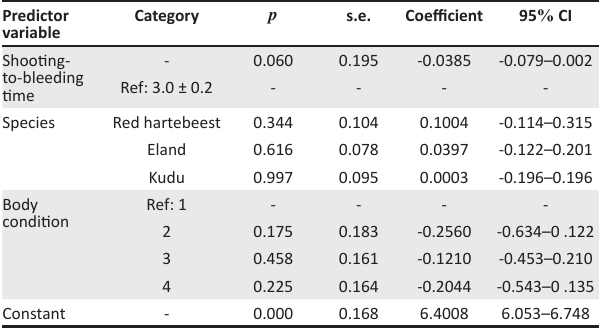
TABLE 5: Results from a multivariable linear regression model of the effect of shooting-to-bleeding time on the pH of game liver 4 h post-slaughter. Predictor variable